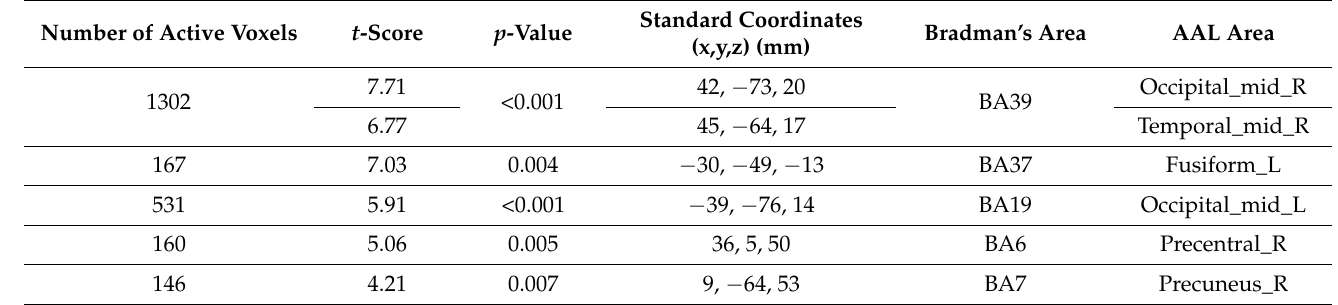
Table 11. Number of people with different takeover modes in six scenarios.